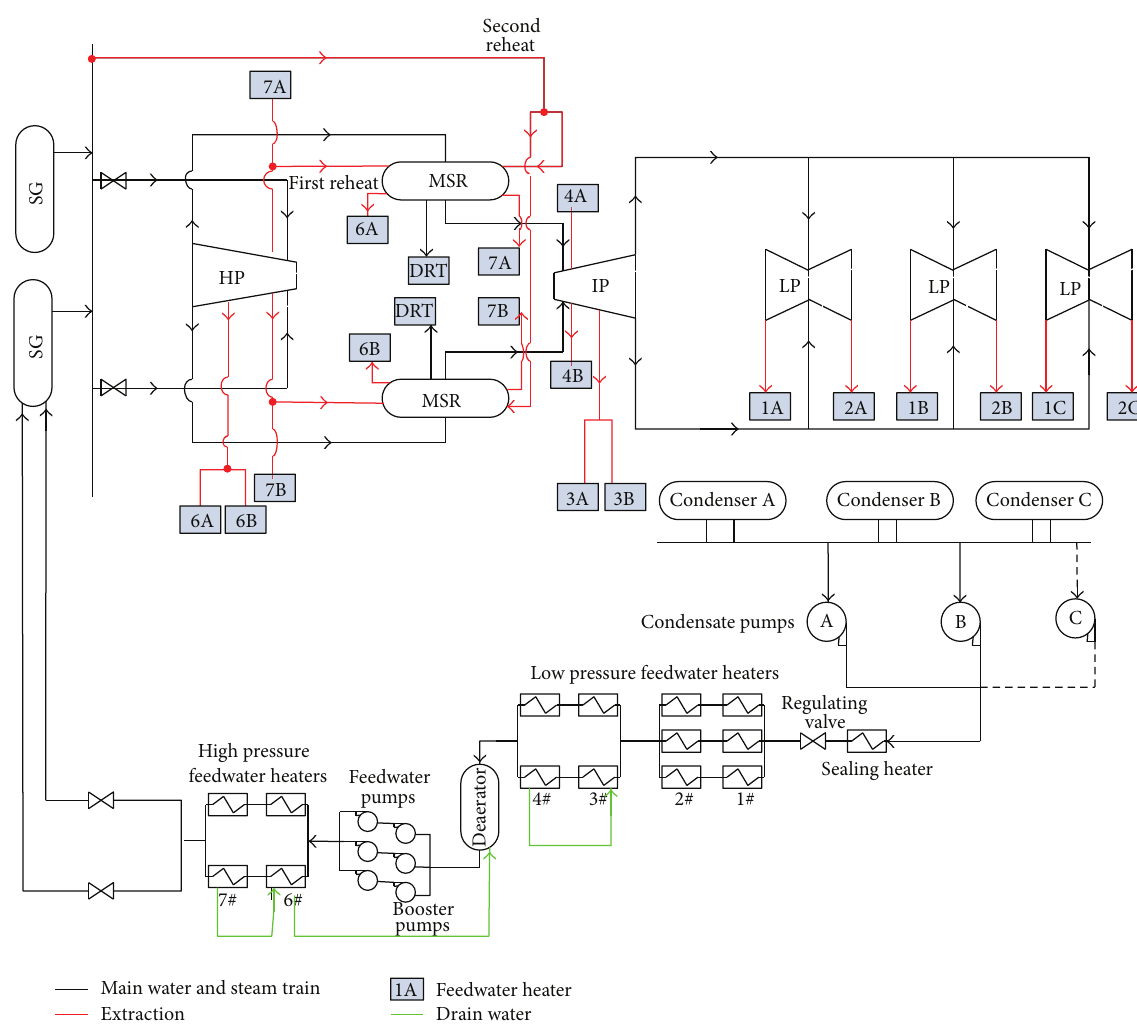
Figure 1: Flow sheet of feedwater and steam system of Chinese large-scale advanced